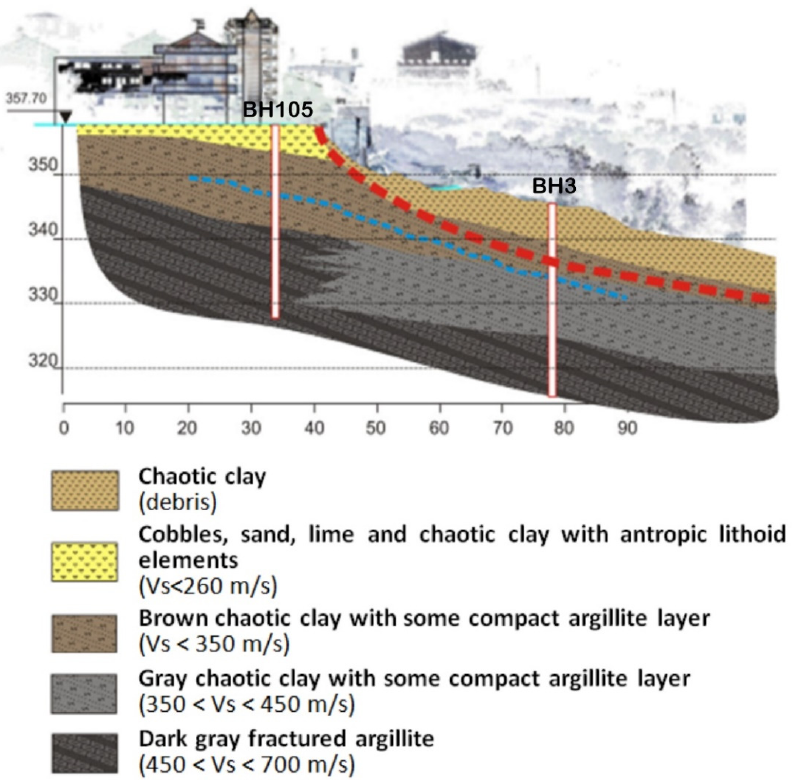
Figure 11. Particulars of the cross-section.